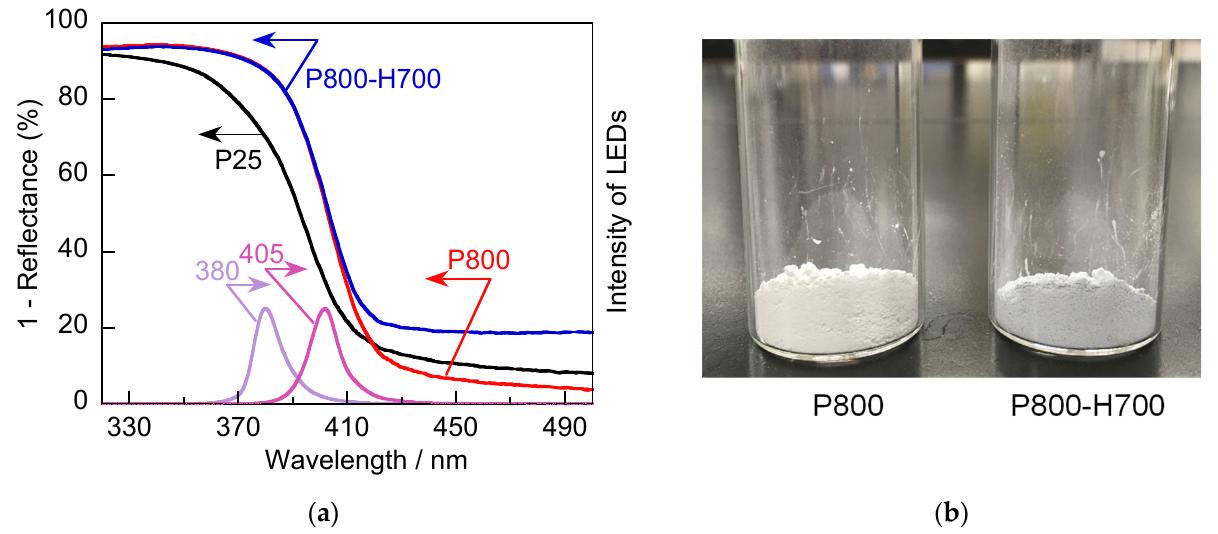
Figure 4. ( a ) Diffuse reflectance UV-visible spectra of TiO 2 samples and emission spectra of 380 and 405 nm light-emitting diodes (LEDs) used for photocatalytic reaction. ( b ) Photograph of TiO 2 powders: P800 and P800-H700.